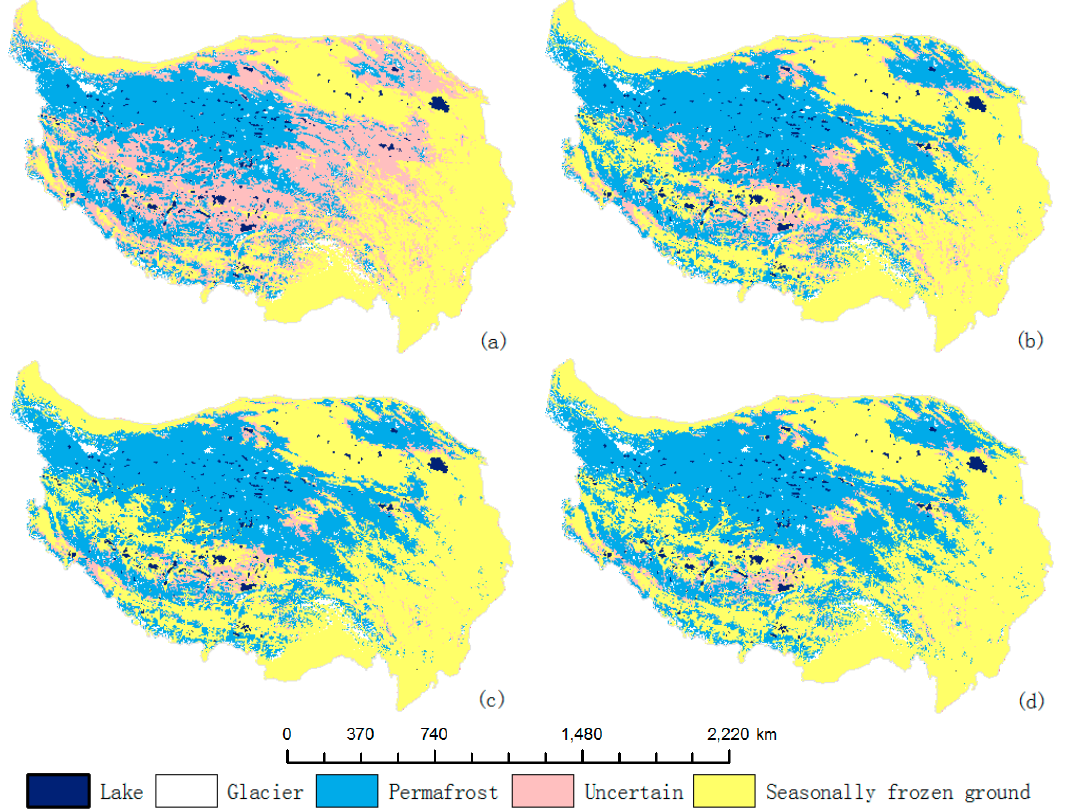
Figure 6. Classification Process Based on Decision Tree Method: ( a ) preliminary classification by elevation; ( b ) further classification by adding LST based on elevation; ( c ) further classification by adding NDVI based on elevation and LST; ( d ) classification by four indicators (elevation, LST, NDVI and soil moisture).